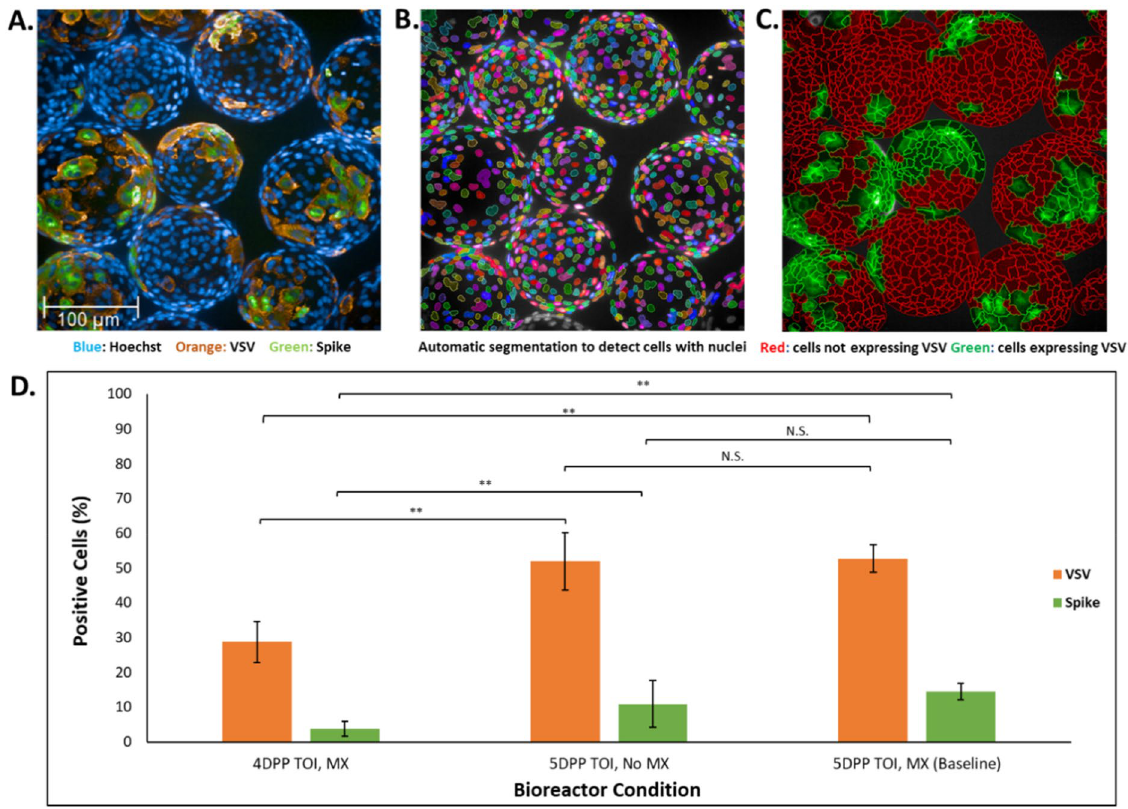
Figure 4. Quantitative high content imaging assay identifies optimal TOI and media condition for virus infection on microcarriers. ( A ) Image of adherent Vero cells on microcarriers stained with anti-VSV, anti-Target protein antibodies (orange and green, respectively) and Hoechst 33342 nucleic acid stain (blue). Image shown is of a single field of view in a single imaging well, taken with 20× water objective on Operetta CLS high content imager. ( B ) Segmented nuclei as identified by Perkin Elmer Harmony software algorithm, using Hoechst 33342 as a guide. Each colorful shape represents a single nucleus from which the software can segment individual cells. ( C ) Results from quantitative analysis performed on Operetta using Harmony software to distinguish cells positive for VSV or Target protein (green) and uninfected cells (red). ( D ) Comparison of the percentage of cells positive for VSV (orange) or Target protein (green) expression plotted for each bioreactor condition tested on X- axis (N = 9). **Indicates statistical significance between conditions ( p < 0.01 for two-tailed Student’s t-test). N.S. indicates no statistical significance between